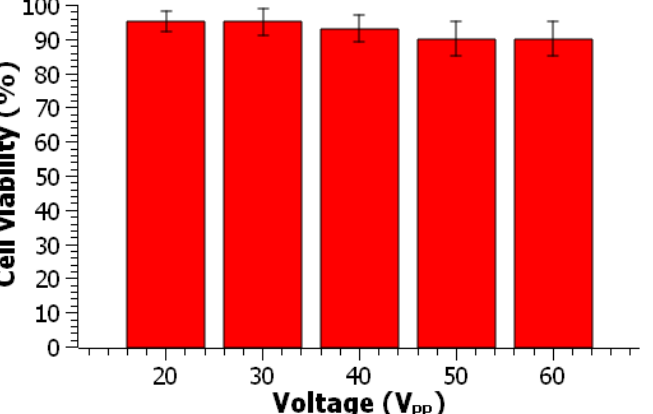
Figure 7. Characterization of HeLa cell viability of acoustic separation. Error bars are standard deviation of 5 measurements.